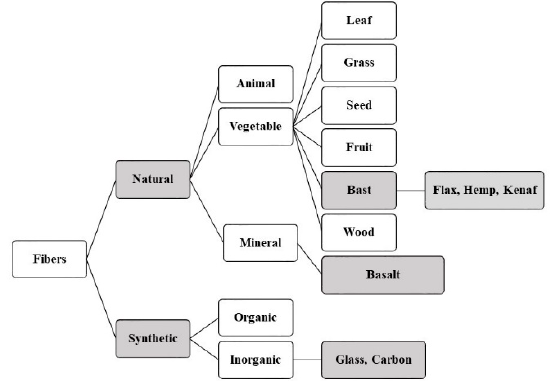
Figure 2. Classification of fibers ([4,6] modified illustration).